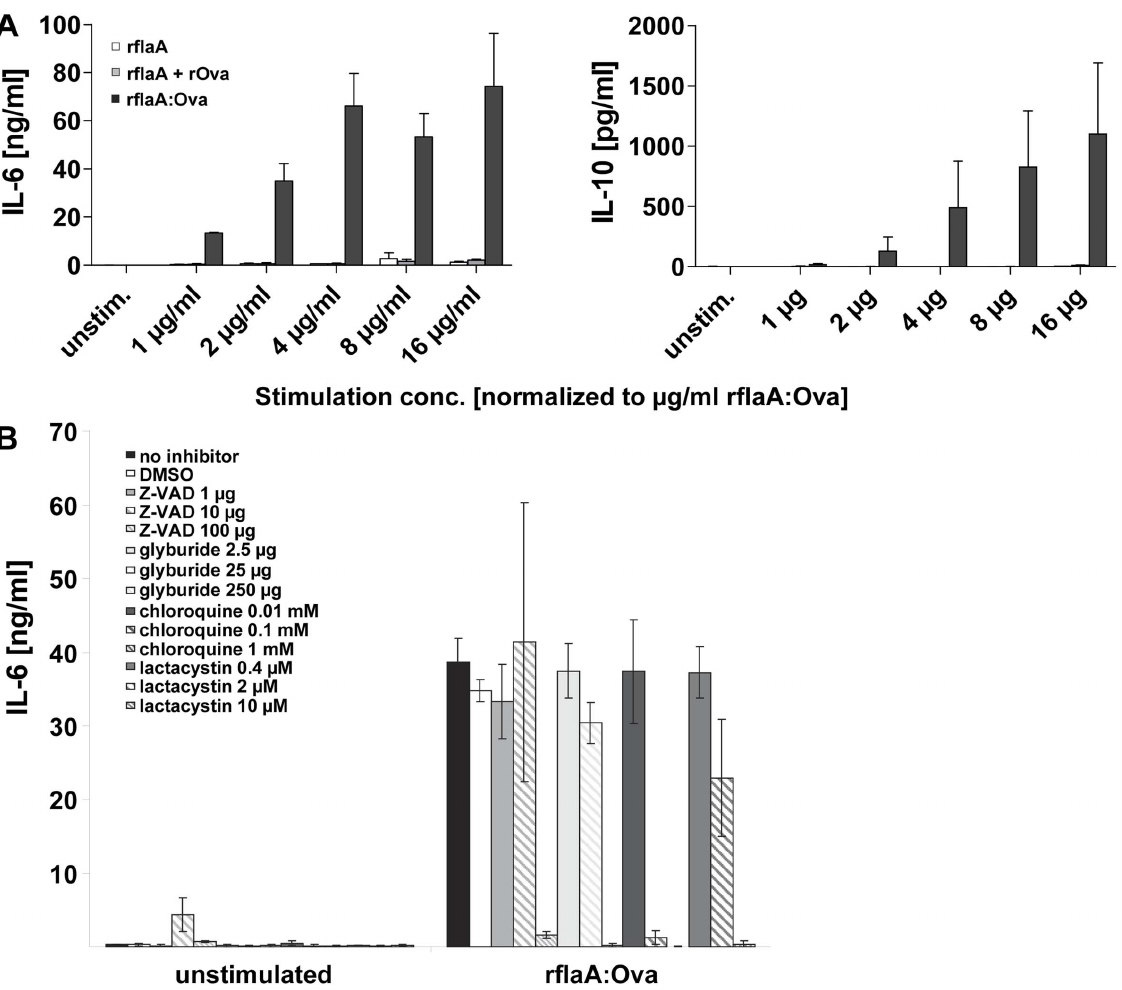
Figure 5. flaA:Ova mediated IL-6 secretion depends on both proteasome and inflammasome activation. BALB/c mDC were stimulated with the indicated equimolar amounts of rflaA, rflaA + rOva and rflaA:Ova for 24 h and the resulting IL-6 and IL-10 secretion in the culture supernatants was analyzed by ELISA ( A ). BALB/c mDC were incubated with either the inflammasome inhibitors Z-VAD-FMK and glyburide (or the proteasome inhibitor lactacystin) for 2 h ( B ). Subsequently mDC were stimulated for 22 h with 4 m g of rflaA:Ova. Supernatants were analyzed for IL-6 secretion via ELISA. Results are mean values of three independent experiments 6 SD. rflaA:Ova induced IL-6 secretion by mDC was unaffected by IL- 10 deficiency of the APC (Fig. 7).